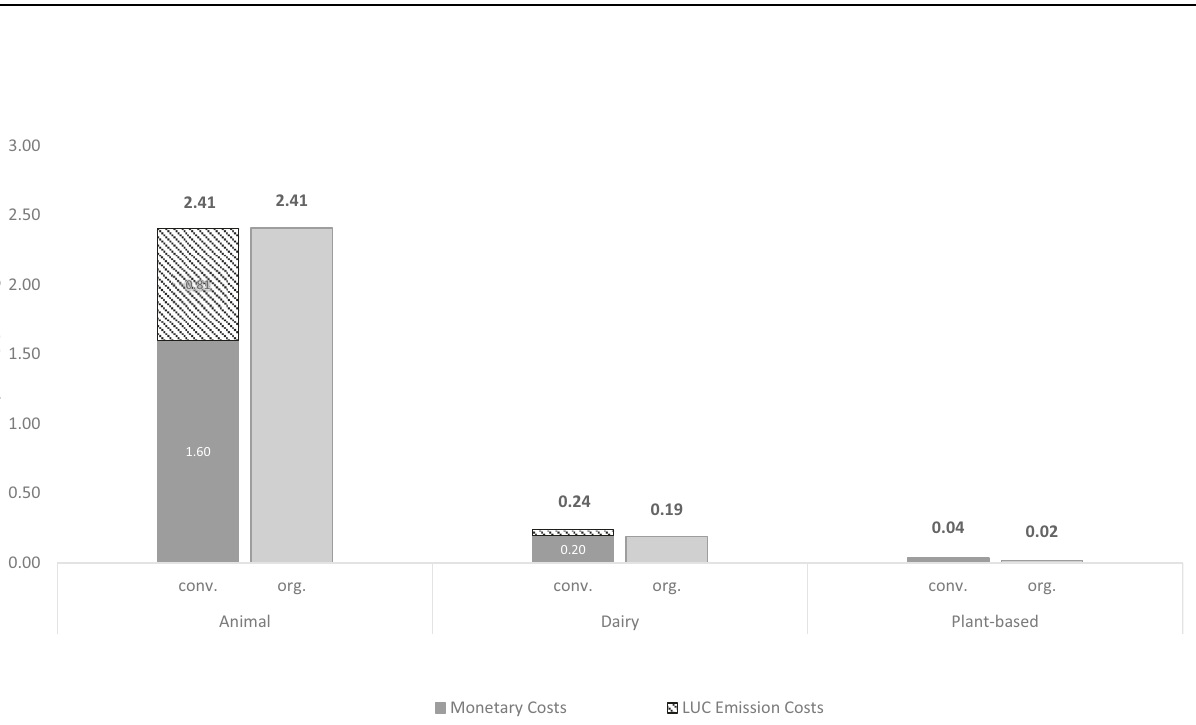
Fig. 1 Visualization of monetary costs for broad food categories. Monetary costs [C] for broad categories (animal-based, dairy, plant-based in the comparison between conventional and organic production) arising from monetized externalities of greenhouse gas emissions. For conventional production (animal-based and dairy), the external costs from land-use change (LUC) emissions are highlighted separately. Source data are provided as a source data fi